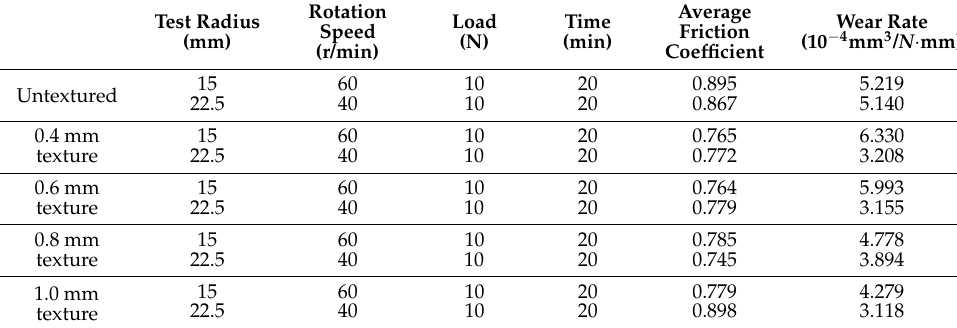
Table 4. Experimental conditions for rotation